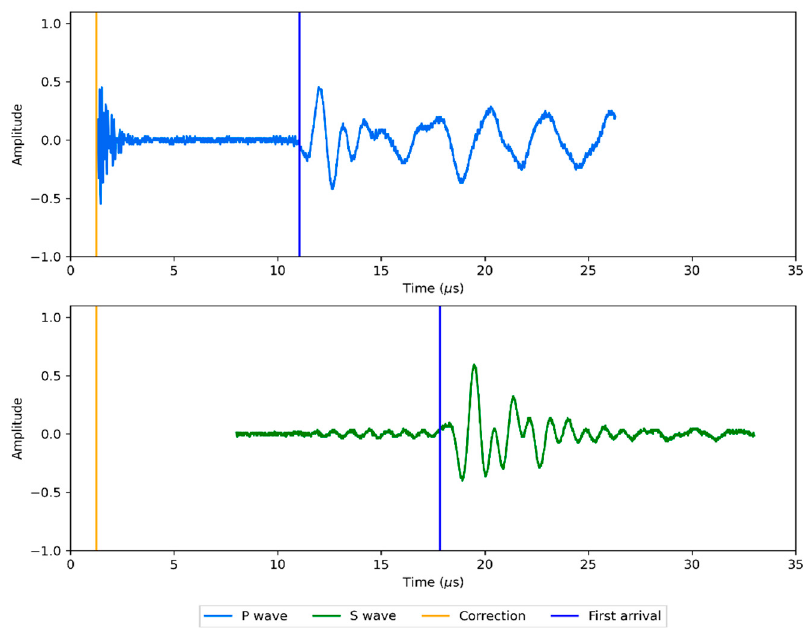
Figure 4. P-wave and S-wave signal of dry sample No. 6.